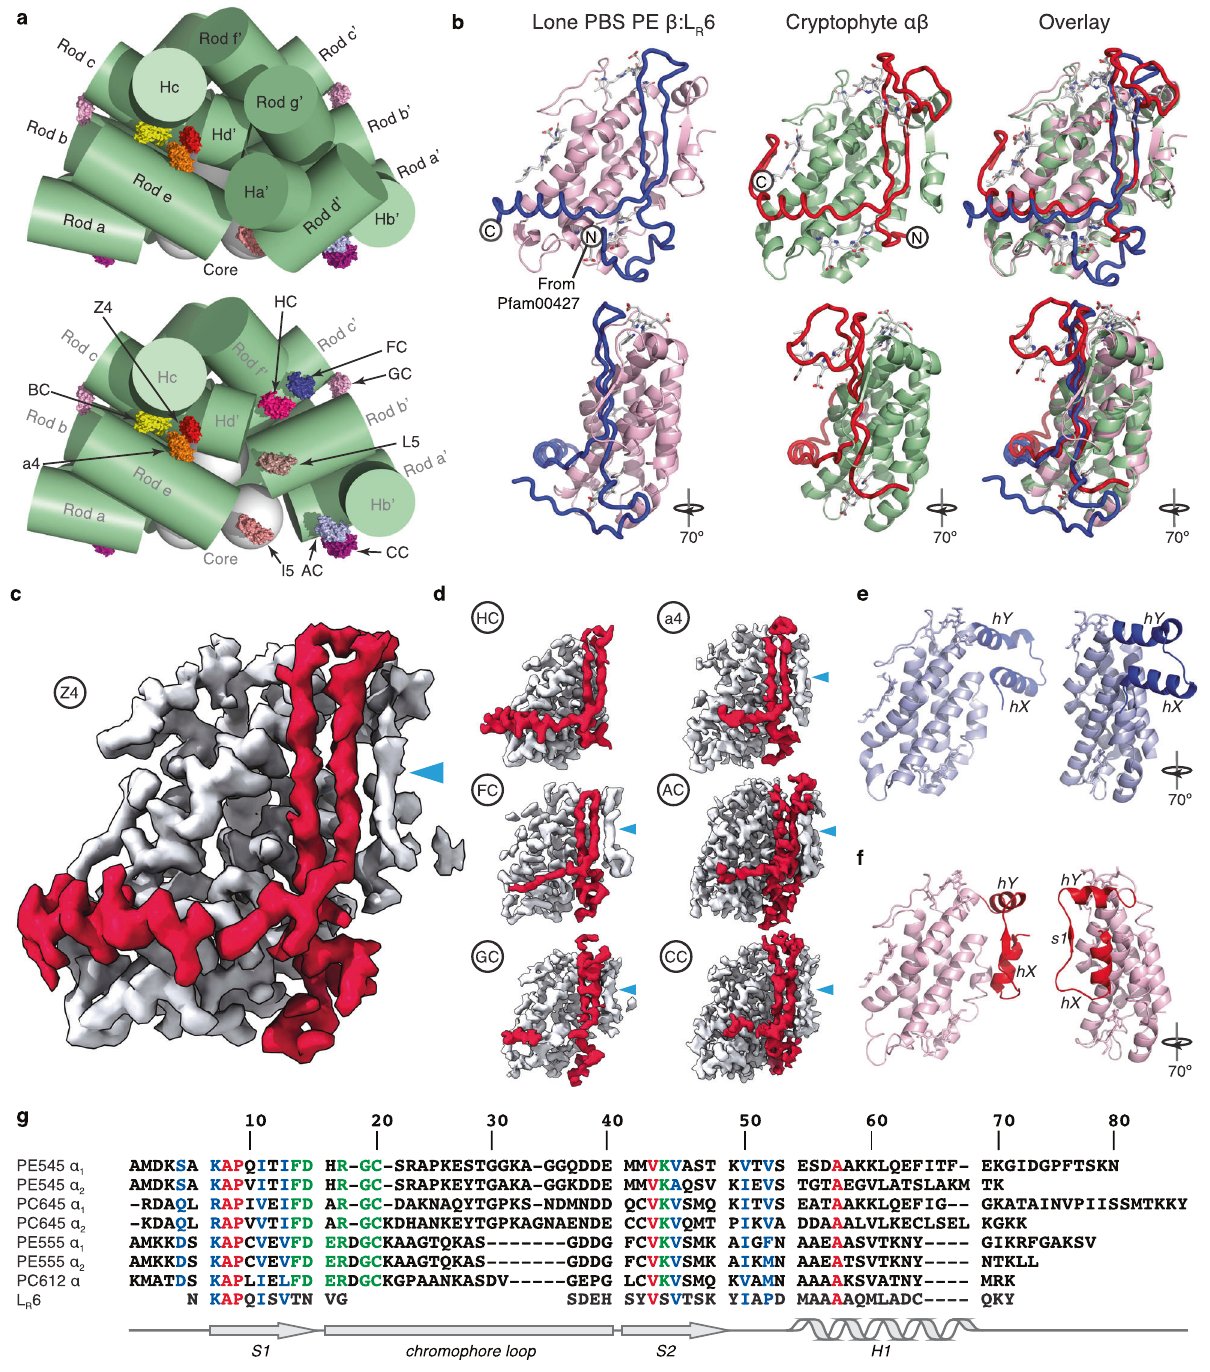
Fig. 1 CALM domain proteins stabilise ‘ lone ’ PE β subunits in the red algal PBS. a ‘ lone ’ PE β subunits (coloured protein surface rendering) peripherally associated to red algal PBS rods (green cylinders) observed in the cryo-EM structure of the red algal PBS from P. purpureum (PDB 6KGX) 10 . Lower panel: Rod d ’ , Rod g ’ and Ha ’ removed. Labelling is according to Ma et al. 10 . b revised model of the C-terminal domain of L R 6 with its cognate PE β subunit is structurally homologous to the cryptophyte- αβ protomer. c , d sculpted EM map density showing cryptophyte-like protomers from the P. purpureum red algal PBS (CALM domains in red and PE β in grey) labelled according to 10 . Cyan triangle indicates the β strand in PE β . e , f comparison of metamorphic states of PE β in two rotations with secondary structure labelled: e the red algal PBS hexamer form and f the cryptophyte-like form. g structure-based sequence alignment of cryptophyte α subunits (PDB 1XG0 (PE545), 4LMS (PC645), 4LMX (PE555), and 4LM6 (PC612)) and the C-terminal CALM domain of L R 6. Red = identity, blue = conserved, and green = chromophore